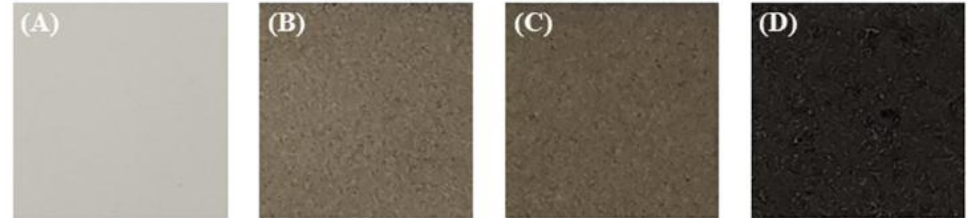
Figure 3. Optical images of the PEO coatings formed in the electrolytes containing different amounts of CNT: ( A ) 0 g/L CNT; ( B ) 2.5 g/L CNT; ( C ) 5 g/L CNT and ( D ) 10 g/L CNT.